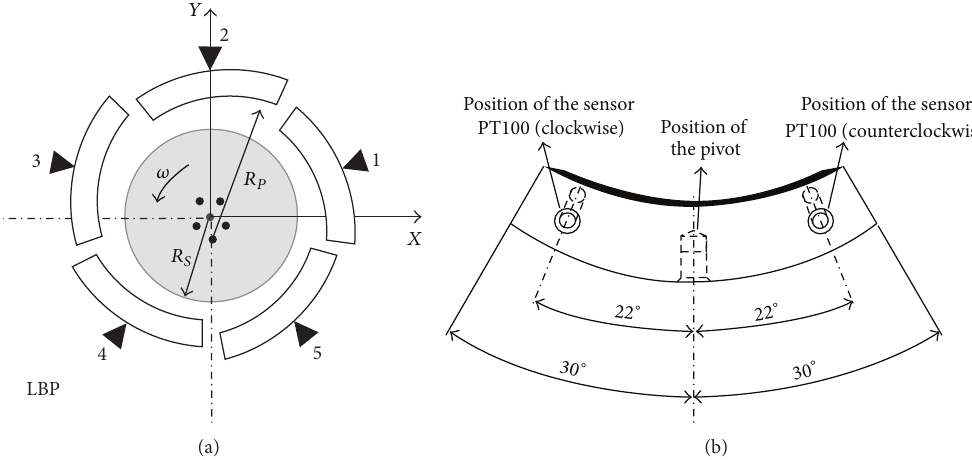
Figure 6: Schematic representation of the bearing and the pad: (a) tilting pad bearing with 5 pads; (b) pad of the bearing.